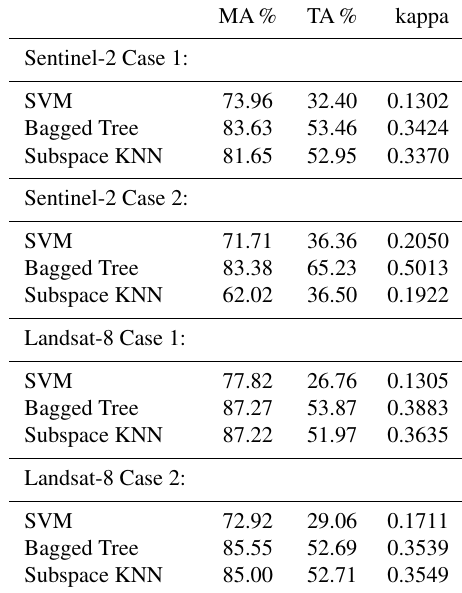
Table 1 states the accuracy achieved using the aforemen-